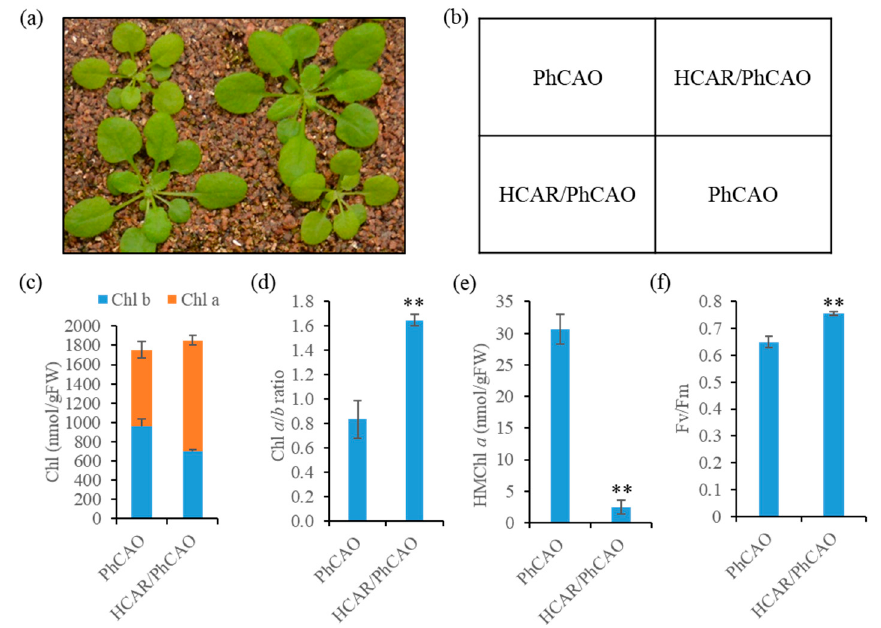
Figure 2. The changes of growth, Chl (chlorophyll) and Chl fluorescence parameters upon overexpressing HCAR (7-hydroxymethyl Chl a (HMChl a ) reductase) in PhCAO ( Prochlirothrix hollandica chlorophyllide a oxygenase-overexpressing). ( a ) PhCAO and HCAR/PhCAO plants and ( b ) their location map. ( c ) Chl a and b contents, ( d ) Chl a / b ratios, ( e ) HMChl a contents and ( f ) Fv/Fm ratios of PhCAO and HCAR/PhCAO plants. Values are means ± SD of three independent experiments. Asterisks indicate significant difference compared to PhCAO (Student’s t -test, ** p < 0.01).